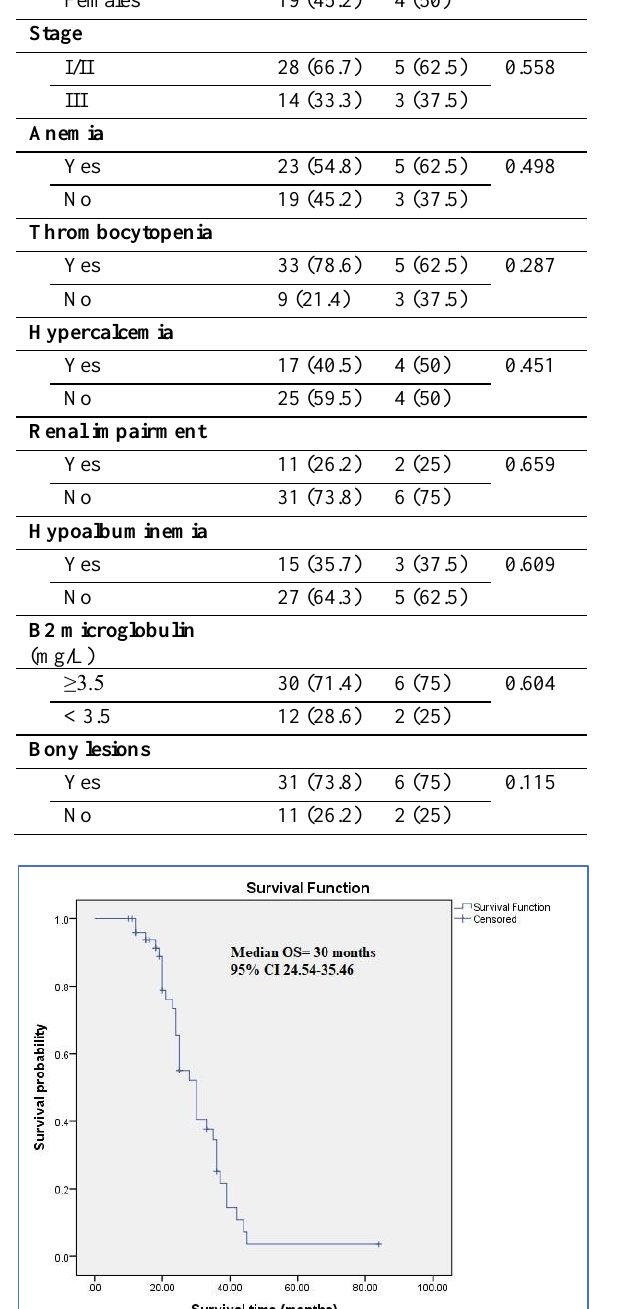
Figure 1: Kaplan Meier curve showing overall survival of all patients